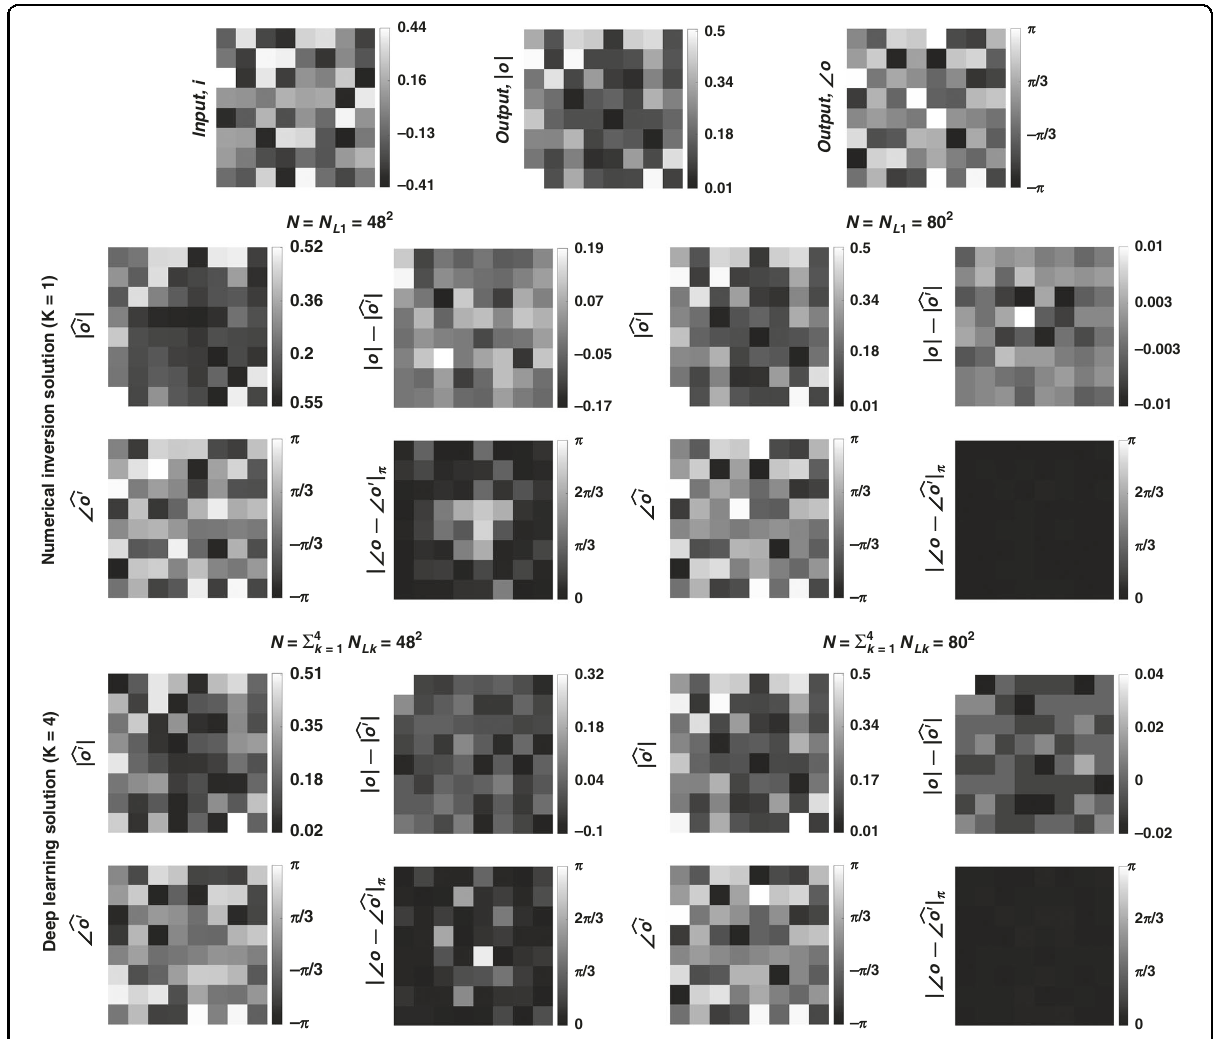
Fig. 9 Sample input – output images for the ground truth transformation presented in Fig. 7b and the optical outputs by the diffractive designs with N = 48 2 and N = 80 2 . The magnitude and phase of the normalized output fi elds and the differences of these quantities with respect (cid:5) (cid:5) (cid:5) (cid:5) to the ground truth are shown. ff o (cid:2) ff b o ′ π indicates wrapped phase difference between the ground truth and the normalized output